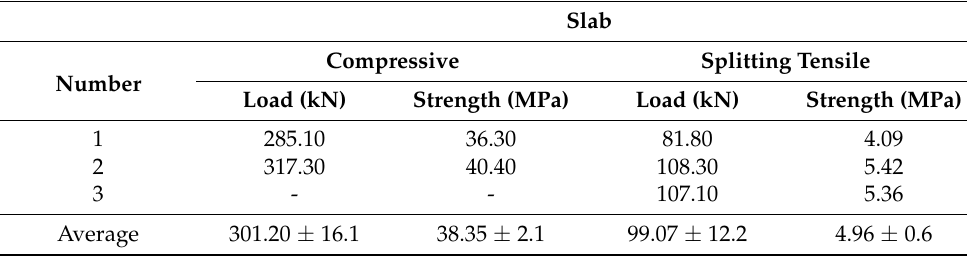
Table 2. Compressive strength and splitting tensile strength of deck.